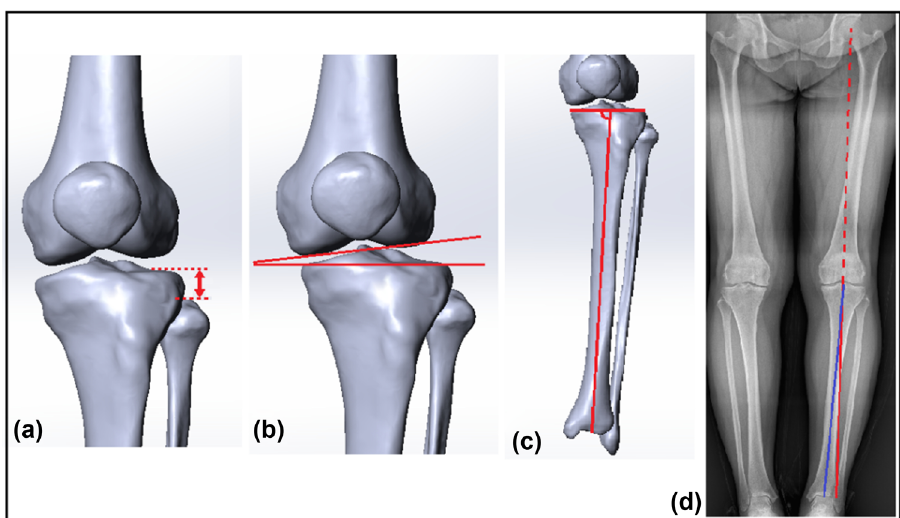
Figure 1: Datameasurement. ( a ) Fibularheadheightisthedistancebetweenthe fi bularheadedgeandthehorizontaltangentthroughthelowestpoint of the lateral tibial plateau. ( b ) JLCA: the angle between the tangent through the lower edge of the medial and lateral femoral condyles and the tibial plateauplane. ( c ) MPTA:themedialanglebetweenthetangentthroughthetibialplateauandthetibialmechanicalaxis. ( d ) Hip – knee – ankleangle:the angle between the extension line downward of the femoral mechanical axis ( blue solid line ) and the tibial mechanical axis ( yellow solid line )